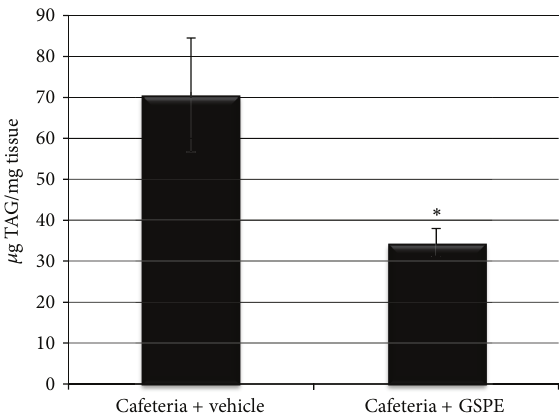
Figure 2: TAG content in the pancreas of cafeteria-fed rats treated with GSPE or vehicle, expressed as 𝜇 g/mg of pancreatic tissue. Data are shown as the mean ± SEM. ∗ 𝑃 ≤ 0.05 .